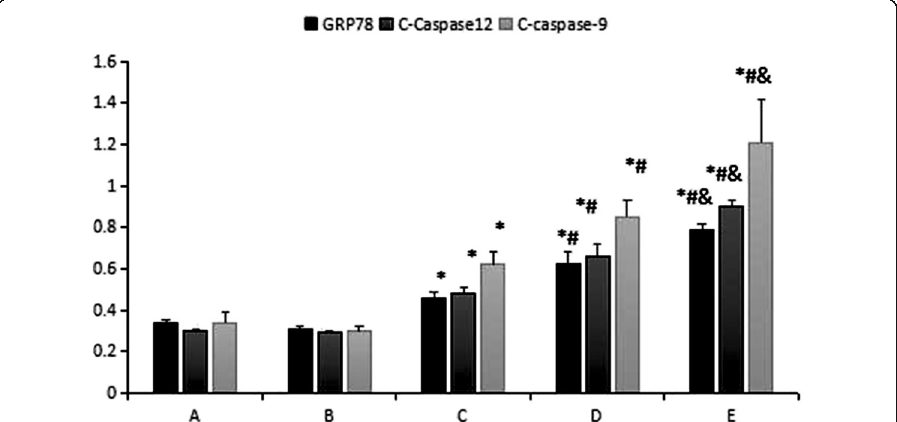
Fig. 7 Expressions of GRP78, C-caspase-12 and C-caspase-9 protein in the different treatment groups of hepatic stellate cells. A – blank group; B – TGF- β 1 group; C, D and E – TGF- β 1 + low, middle and high dose calcium ionophore A23187 groups. *p < 0.05 compared to the blank group; # p < 0.05 compared to the TGF- β 1 group; & p < 0.05 as compared to the TGF- β 1 + low dose of calcium ionophore A23187